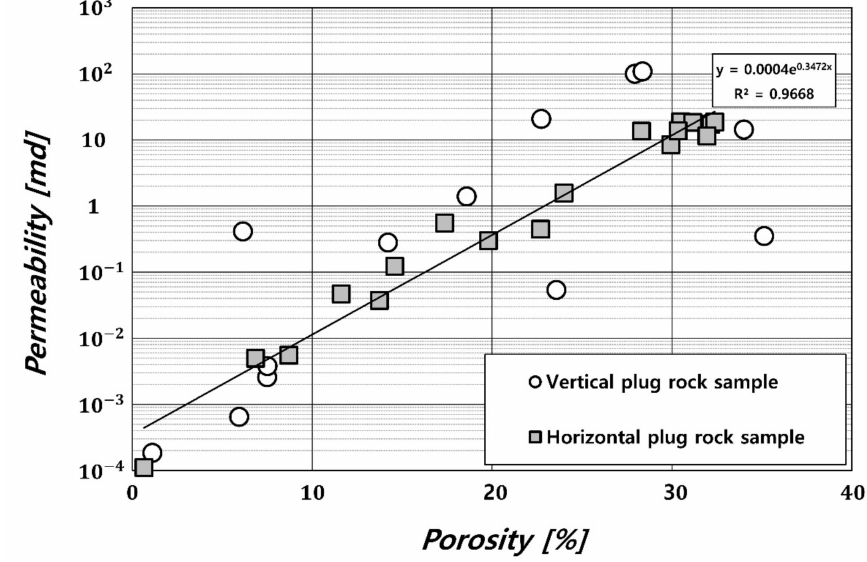
Figure 8. Relationships between porosity and both vertical and horizontal